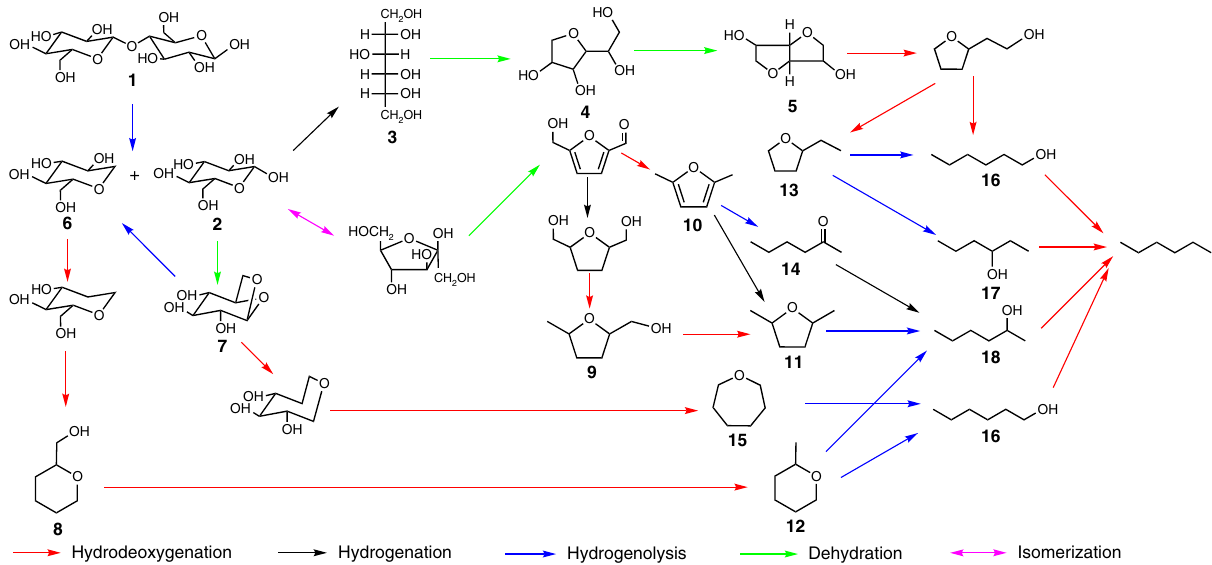
Figure 2 | Representative reaction pathways for the direct hydrodeoxygenation of cellobiose. According to all the intermediates detected, it is possible to deduce the main reaction pathways of the direct conversion of cellobiose to hexane. The reaction occurred by the direct hydrogenolysis of the b -1,4 linkage to D -glucose ( 2 ) and 1-deoxy- D -glucose ( 6 ) first, and then 6 was converted to hexane by sequential hydrogenolysis via 2-hydroxymethyl- tetrahydropyran ( 8 ), 2-methyltetrahydropyran ( 12 ) and hexanols ( 16 ) and ( 18 ), whereas the conversion of 2 has three main reaction pathways: (i) hydrogenated to sorbitol ( 3 ) and then dehydrated to sorbitan ( 4 ) and isosorbide ( 5 ), followed by sequential hydrogenolysis via 2-ethyl-THF ( 13 ) and hexanols ( 16 ) and ( 17 ). (ii) Isomerised to fructose and then dehydrated to 5-hydroxymethylfurfural followed by hydrogenation and sequential hydrogenolysis via 2,5-dimethylfuran ( 10 ), 2-hexanone ( 14 ), 5-methyl-THF-2-methanol ( 9 ), 2,5-dimethyl-THF ( 11 ) and 2-hexanol ( 18 ). (iii) Dehydrated to 1,6-anhydroglucose ( 7 ) followed by sequential hydrogenolysis via oxepane ( 15 ) and n -hexanol ( 16